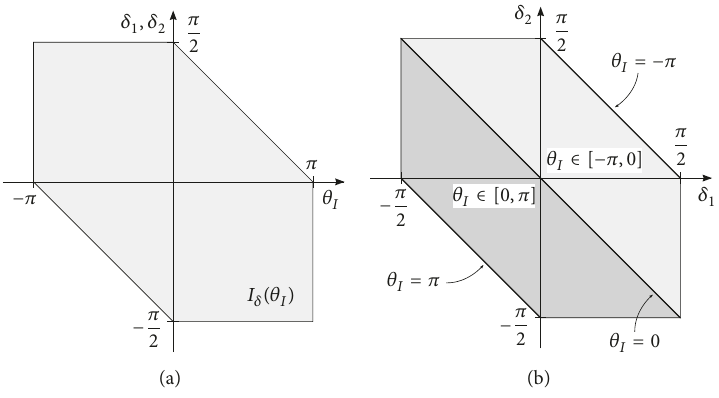
Figure 5: Set of valid (𝛿 1 ,𝛿 2 ) pairs for EES paths.